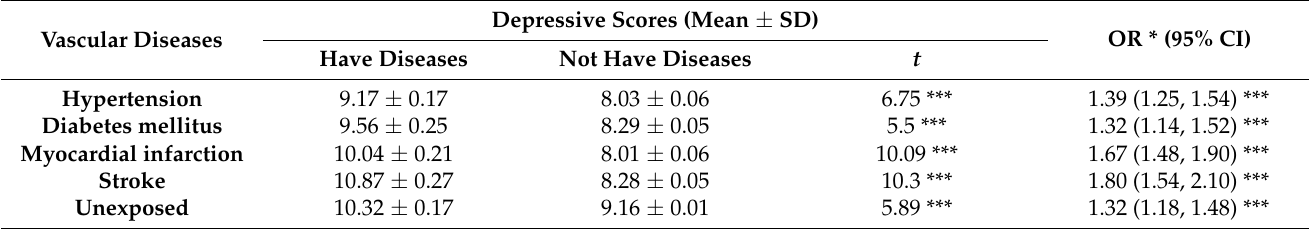
Table 2. Scores and odds ratio of depression in the presence of vascular